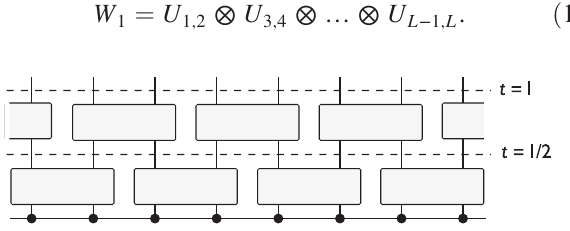
FIG. 1. Illustration of the model for Floquet time evolution studied in this paper. Space and time are represented by the horizontal and vertical directions. Lattice sites are indicated by filled dots, and the coupling of pairs of sites under time evolution is shown with